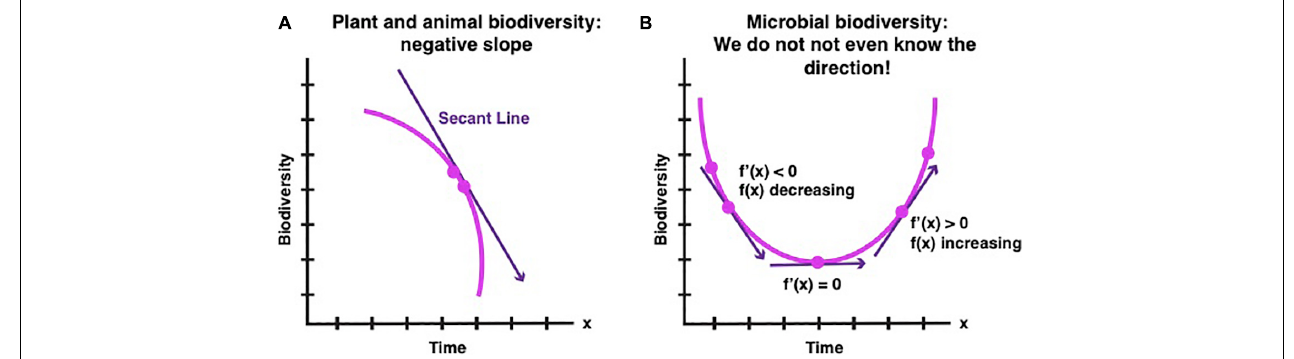
FIGURE 1 | (A) In pre-calculus, the secant is a straight line connecting two points on a curve. The present-day approach to measure changes in biodiversity is to count the number of species at different times and determine the slope of the secant. In the case of animal and plant biodiversity the slope of the secant is negative. (B) The breakthrough of calculus allows defining and finding the slope at a single point. A breakthrough analogous to calculus would be tremendously helpful to determining the trajectory of microbial biodiversity because the secant approach is in many cases difficult or seemingly impossible to implement.